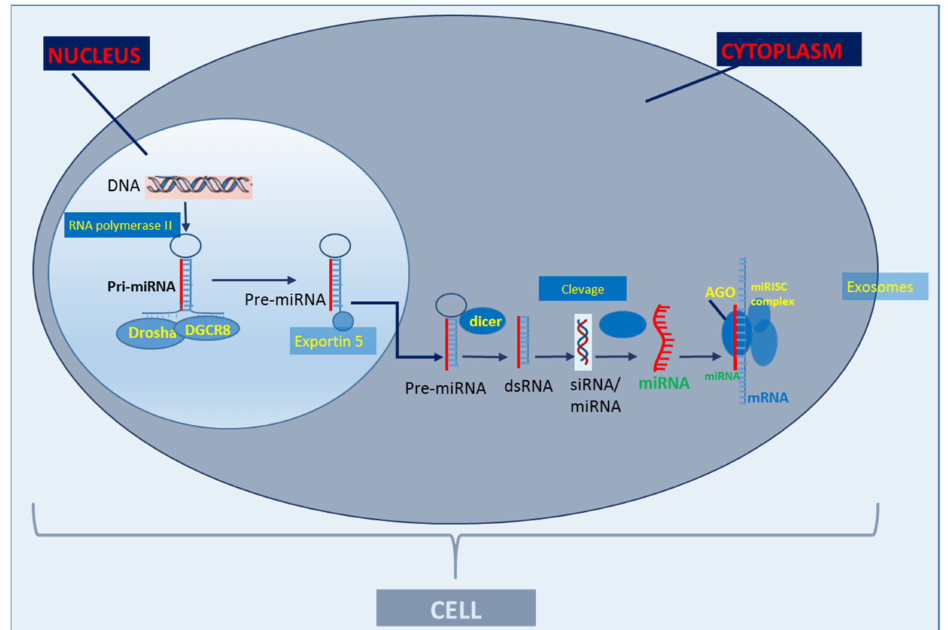
Figure 1. Basic scheme of classic miR biogenesis. The primary miRNA (Pri-miRNA) is produced in the cell nucleus through the transcription of a DNA strand mediated by RNA polymerase II. After transcription, Pri-miRNA is cleaved by the enzymatic complex DROSHA in a micro-RNA precursor (pre-miRNA). Pre-miRNA is exported to the cytoplasm by exportin-5 and cleaved by dicer (RNA degrading enzyme) and produces approximately 22 nucleotide RNA duplexes. A miRNA strand is transferred to the Argonaute complex (AGO), forming an RNA-induced silencing complex (RISC) and guides it to pair with the target messenger RNA (mRNA) through binding the miRNA seed sequence with the miRNA recognition site in the mRNA. miRs are secreted out of cells via exosomes (adapted from Creemers et al., 2012